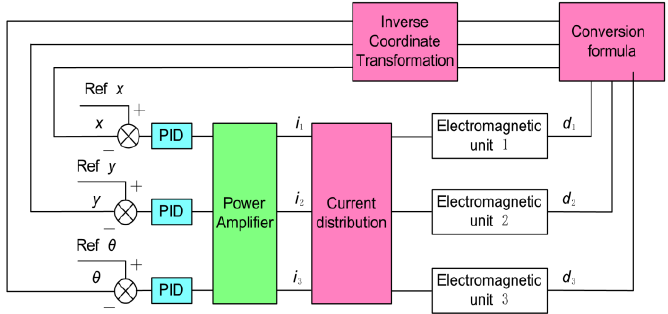
Figure 6. Block diagram of the control system.